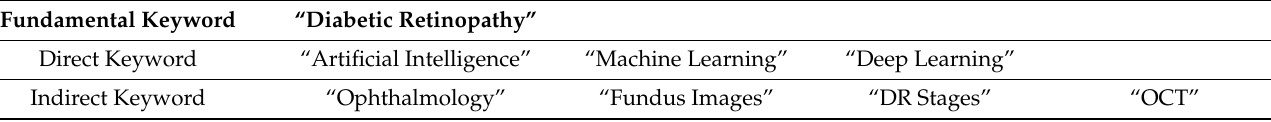
Figure 7. Demonstrates the organization of our SLR into various portions. Table 2 provides a list of research questions used in SLR. The identification of information sources is the second phase in our SLR. Databases such as Scopus and Web of Science were used to find related papers. Some general and specific keywords are included in Table 3 that can be used to create search queries for finding research publications. Table 3. Direct and indirect keywords were used.